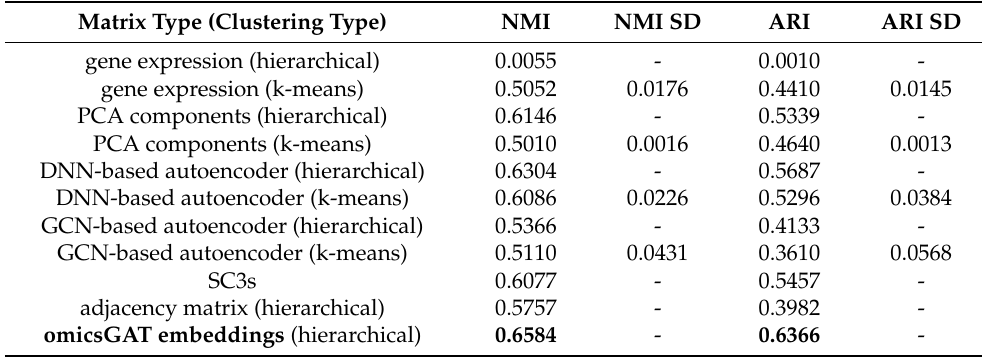
Table 4. The clustering performance on H3K27M-gliomas scRNA-seq data. The NMI and ARI scores of omicsGAT Clustering and baseline methods are reported in the table. Hierarchical clustering was computed with ‘Cosine’ distance and ‘Average’ linkage. Mean NMI and ARI scores with standard deviation (SD) are reported for k-means clustering (run 10